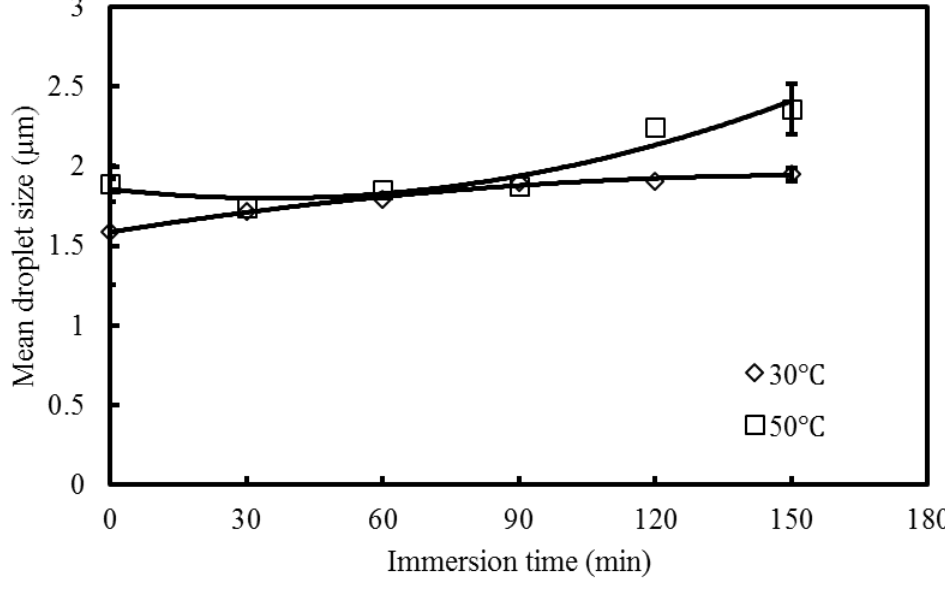
Figure 1. Variations in the mean droplet size in the microalgae biomass at different immersion times in a 0.54 M KCl solution at 30 °C and 50 °C.